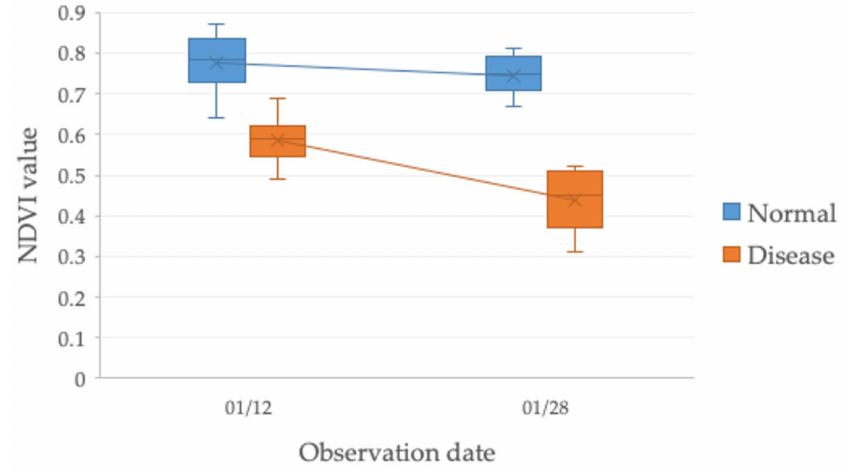
Figure 13. Boxplot showing the correlation between NDVI values and Fusarium wilt disease on 12 January 2018 and 28 January 2018. The graph shows a negative trend in NDVI, with higher values in healthy radish and lower values in radish infected with wilt disease, with lowest NDVI values recorded for the radishes at the late stage of wilt